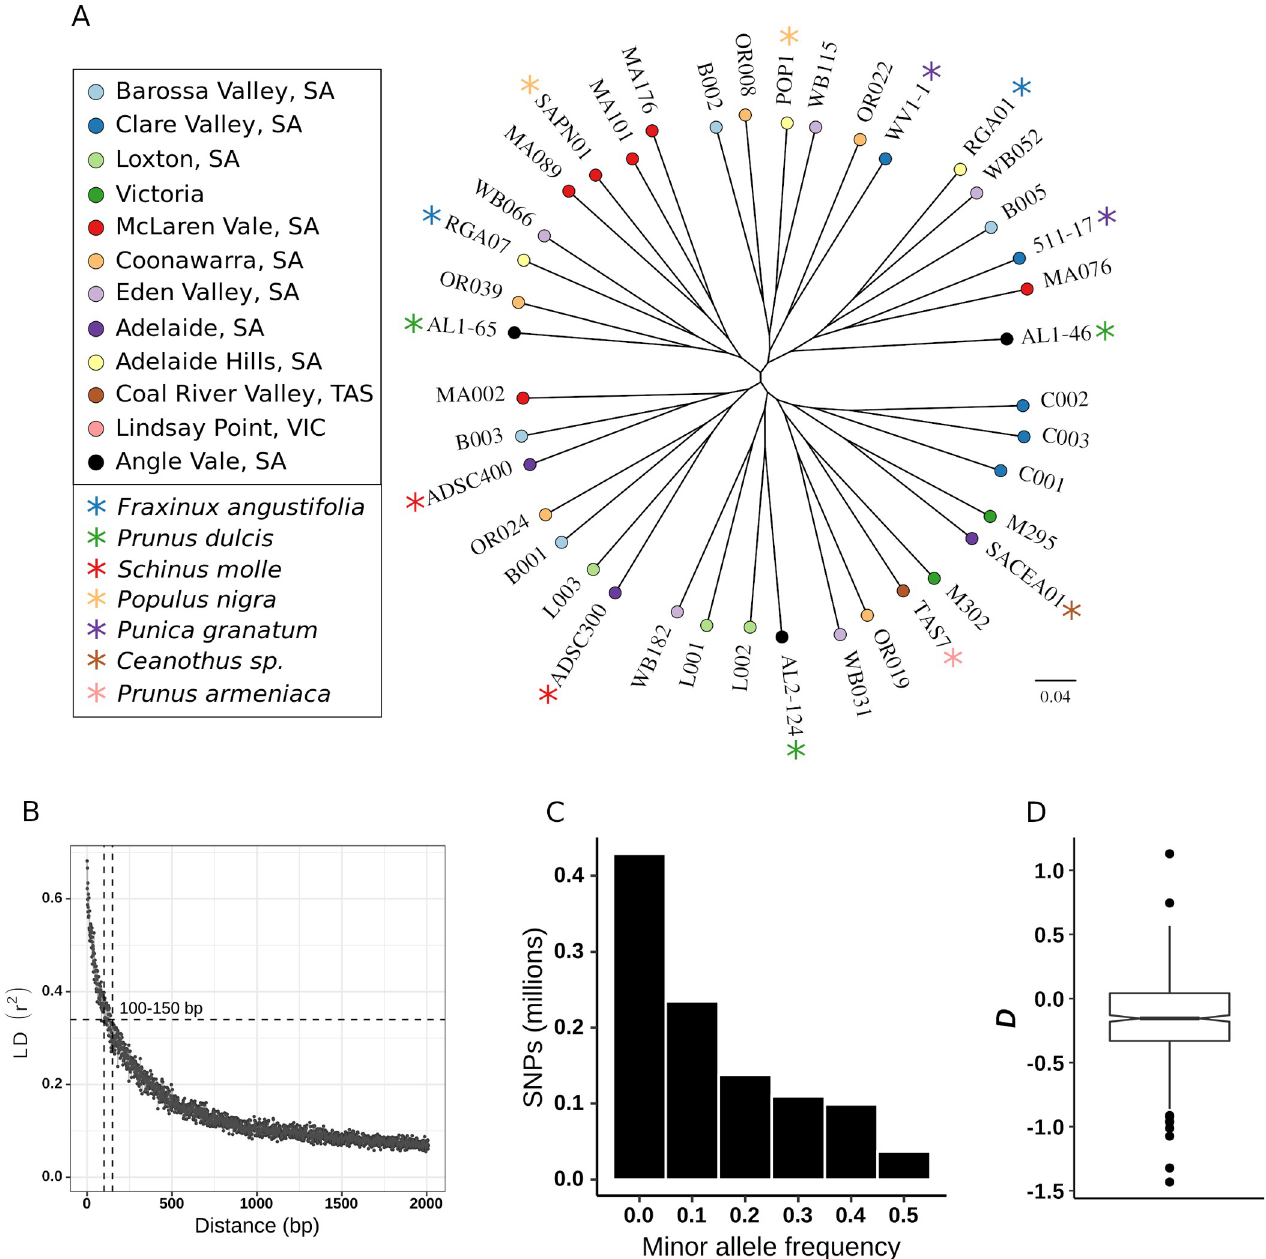
Fig 1. Genetic diversity within 40 Australian Eutypa lata isolates. A. Maximum-likelihood phylogenetic tree constructed from 740,941 single nucleotide polymorphisms (SNPs). Isolation location and host are indicated in the legend. Isolates without an asterisk ( � ) were isolated from Vitis vinifera . B. Linkage disequilibrium (LD) decay on all bi-allelic SNPs present in the largest contig (6.7 Mbp). Data is presented as the squared correlation coefficient (r 2 ) between pairs of SNPs averaged in 1 bp windows. Dotted lines indicate half of the maximum observed value and the corresponding physical distance. C. Minor allele frequency spectrum of SNPs present in all samples. D. Boxplot of Tajima’s D distribution calculated per 100 kbp windows.